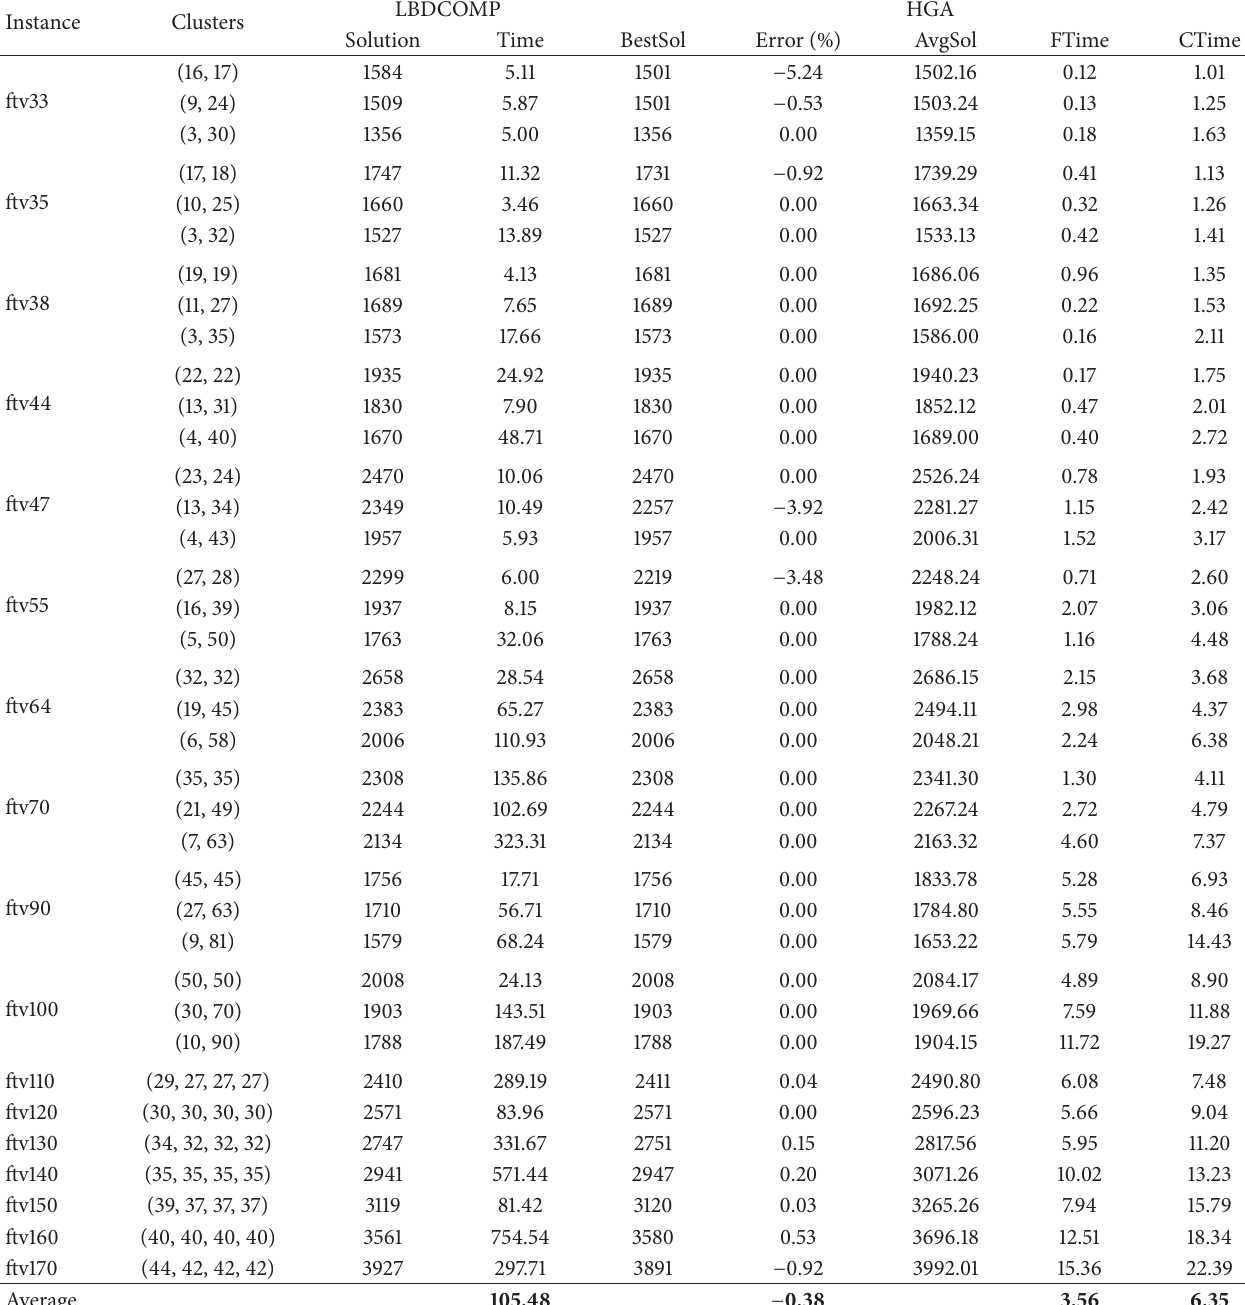
Table 5: A comparative study between LBDCOMP and HGA for asymmetric TSPLIB